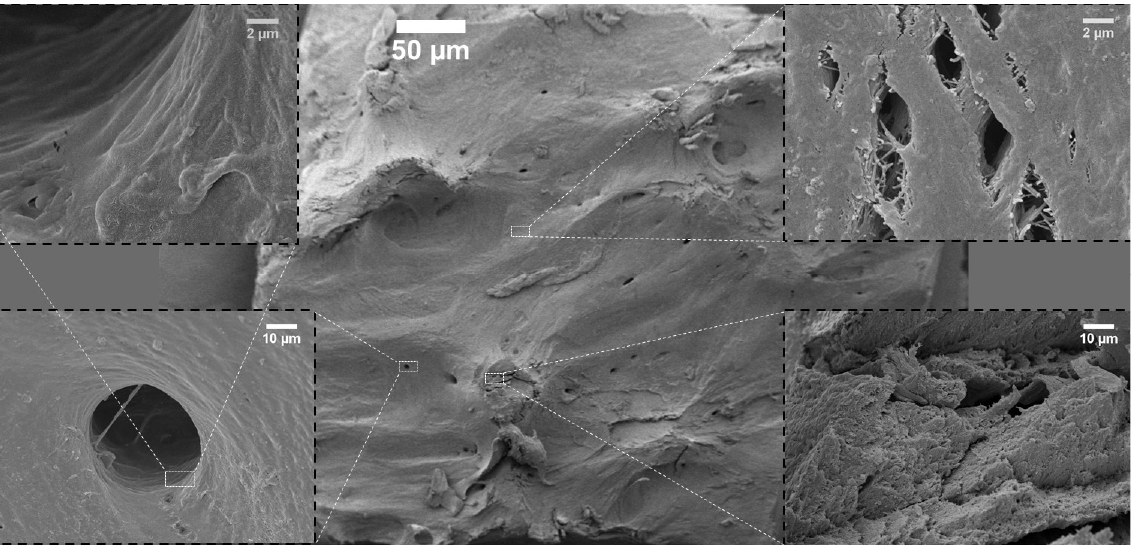
Figure 2. SEM images of Allograft-Katowice.